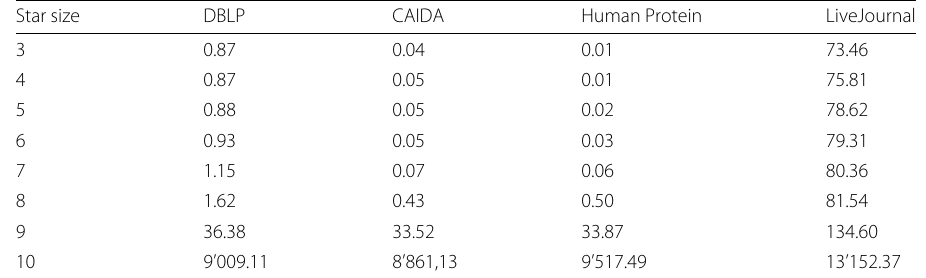
Table 4 Running time (seconds) of RaME for the computation of the mean of induced counts of star topologies with 3-10